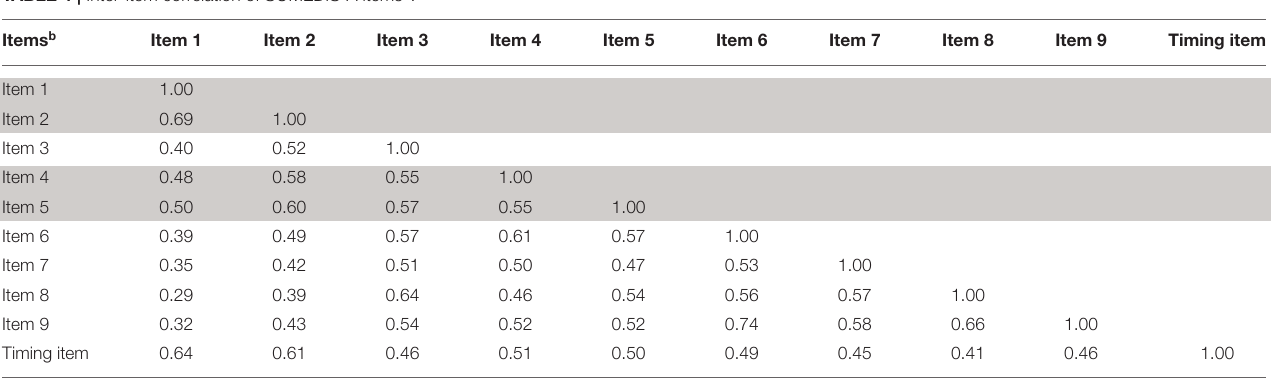
TABLE 4 | Inter-item correlation of SOMEDIS-A items a